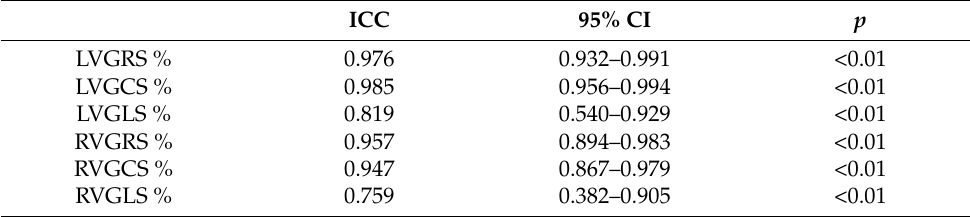
Figure 3. Bland-Altman plots for interobserver variability. Bland-Altman plots for interobserver variability obtained for global LV strain and global RV strain. LV, left ventricular; RV, right ventricular; GRS, global radial strain; GCS, global circumferential strain; GLS, global longitudinal strain. Table 2. Interobserver consistency analyses.